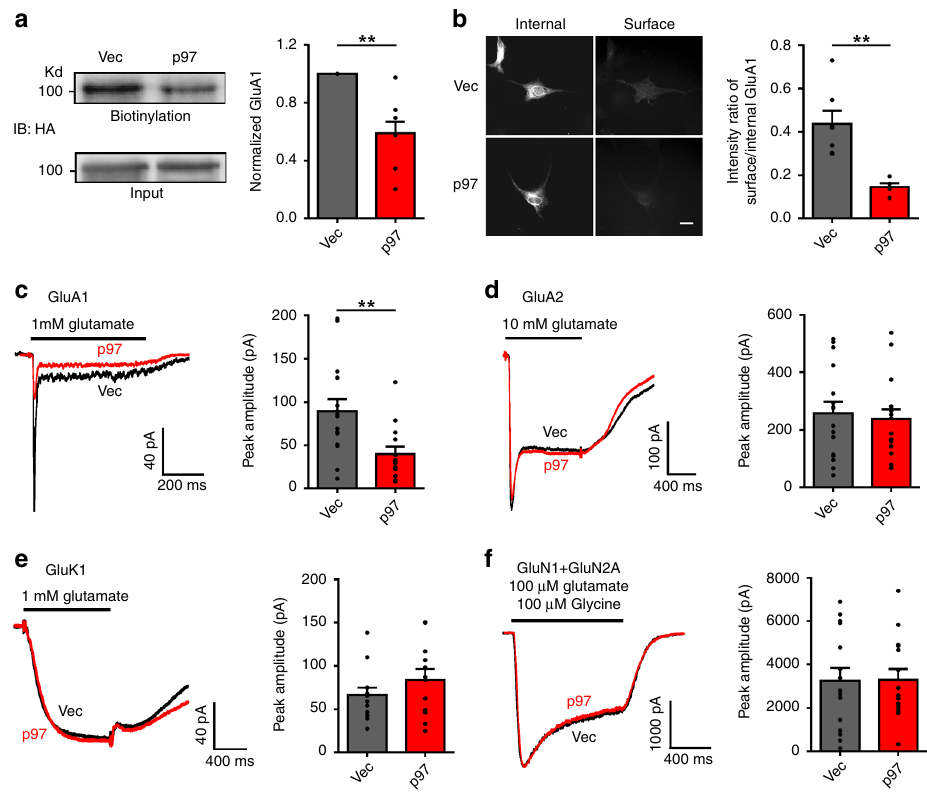
Fig. 3 p97 decreases cell surface recombinant GluA1-homo AMPARs. a , b p97 reduces surface expression of GluA1-homo AMPARs in COS7 cells. HA- GluA1 was transfected with vector (Vec) or p97. Surface expression of GluA1-homo AMPARs were assayed with surface biotinylation ( a ; n = 6 repeated experiments, ** p < 0.01, two-tailed t test) or immuno fl uorescent microscopic examination following sequential nonpermeabilized (Surface) and permeabilized (Internal) staining ( b ; Vec: n = 8 coverslips; p97: n = 6 coverslips; ** p < 0.01, two-tailed t test; Scale bar represents 20 μ m). c – f Whole-cell currents were induced with fast application of saturating concentration of agonizts on HEK293 cells transfected with HA-GluA1 ( c ), GluA2 ( d ), GluK1 ( e ), or GluN1 + GluN2A ( f ) and control vector (Vec) or p97, along with GFP to detect the transfected cells for recording. p97 decreased the peak amplitude of GluA1-homo receptor-mediated currents ( c ; Vec: n = 15 cells; p97: n = 14 cells; ** p < 0.01, two-tailed t test), without changing that of GluA2 homomeric receptor ( d ; Vec: n = 16 cells; p97: n = 16 cells), GluK1 homomeric receptor ( e ; Vec: n = 13 cells; p97: n = 12 cells), or GluN1 + GluN2A receptor ( f ; Vec: n = 15 cells; p97: n = 15 cells) mediated currents. The error bars represent